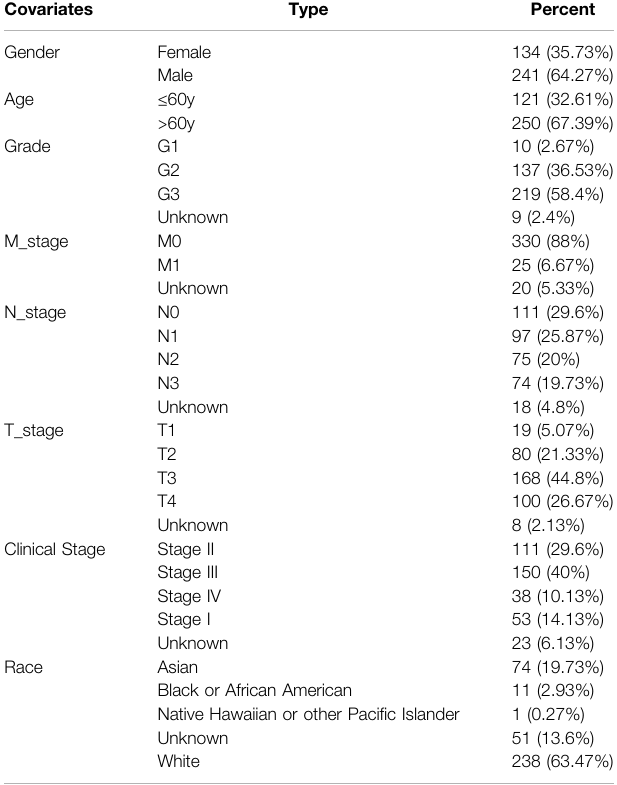
TABLE 1 | The clinical parameters in TCGA gastric cancer cohort.